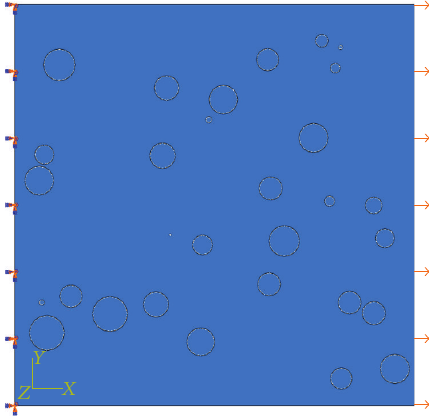
𝑋𝑌 𝑍 Figure 7: RVE displacement-loading schematic. size. A random particle distribution RVE sample is shown in Figure